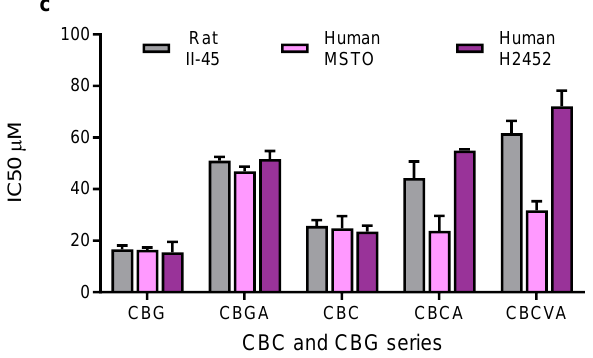
Figure 1. Phytocannabinoids reduce the proliferation of mesothelioma cell lines. The drug con- centration causing 50% growth inhibition (IC50) of ( a ) ∆ 9 -tetrahydrocannabinol (THC) related, ( b ) cannabidiol (CBD) related, and ( c ) cannabichromene (CBC) and cannabigerol (CBG) related phyto- cannabinoids against rat II-45 and human MSTO and H2452 mesothelioma cell lines were determined. Cell viability was assessed using MTT assays in the presence of phytocannabinoid as indicated. Bars show the mean and standard deviation (SD) from at least three independent experiments.